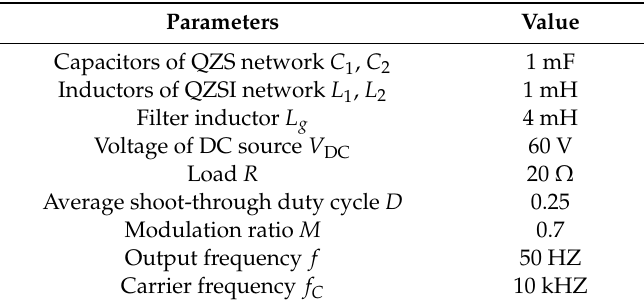
Table 1. Parameters of the single-phase